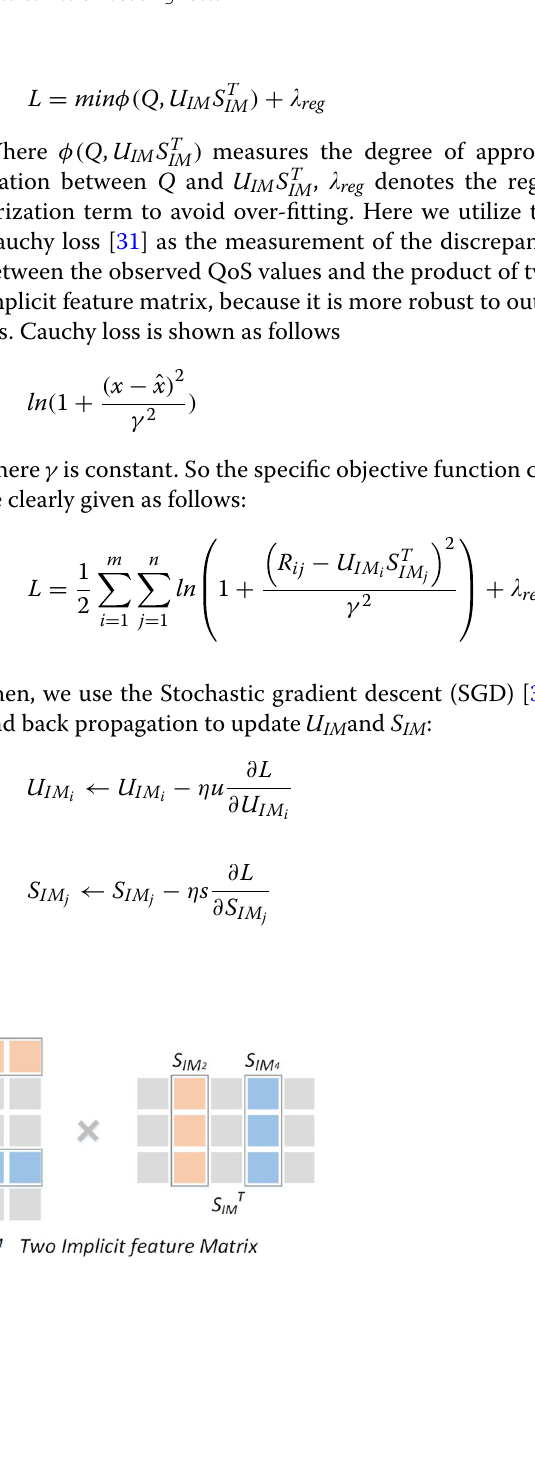
Fig. 3 Illustration of input and embedding layer, where convert the explicit features into embedding vector